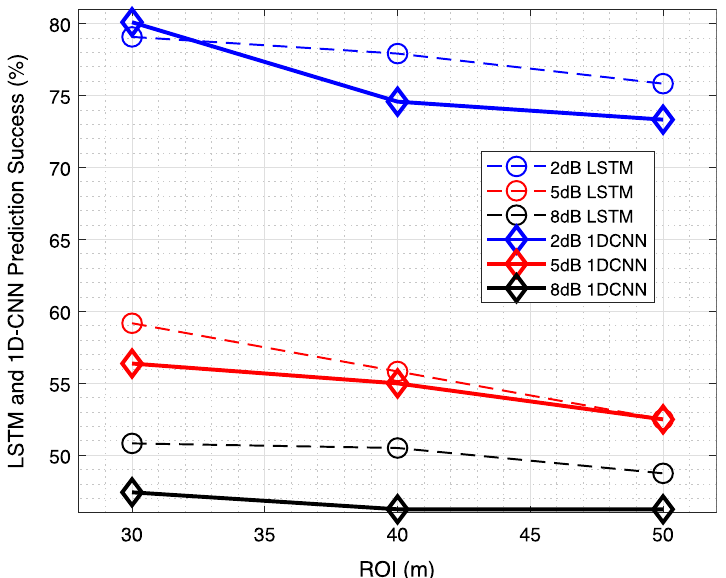
Fig. 6 Accuracies of LSTM and 1D CNN for all shadowing conditions and ROI